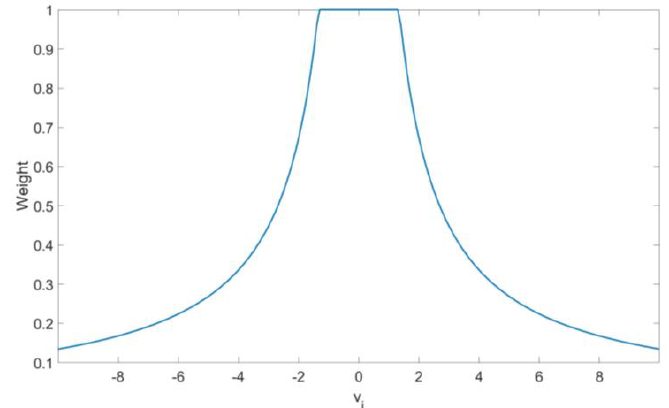
Figure 4. Huber weight function.